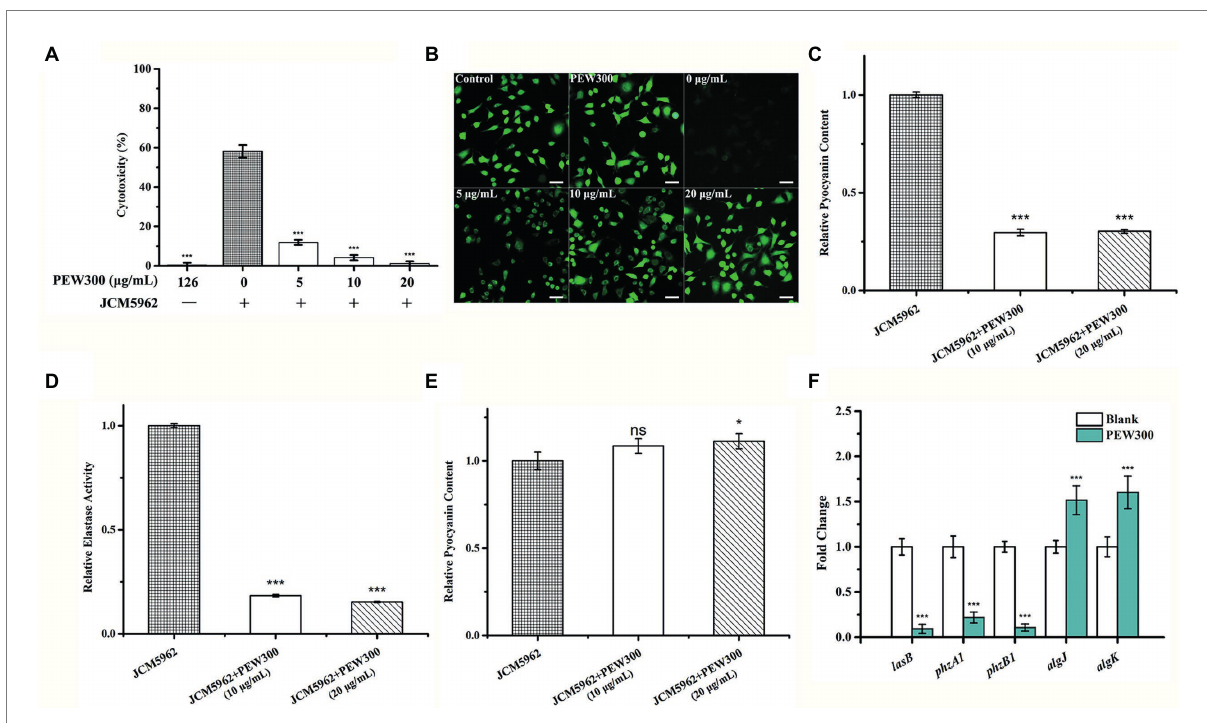
FIGURE 9 Analysis of Pseudomonas aeruginosa virulence factors affected by PEW300. PEW300 results in decreased virulence of P. aeruginosa JCM5962 in A549 cells characterized by (A) CCK-8 assay and (B) calcein-AM staining. *** p < 0.005 compared with P. aeruginosa JCM5962-treated group. Scale bar is 100 μ m. Comparative analysis of (C) pyocyanin content, (D) elastase activity and (E) alginates content in P. aeruginosa JCM5962 treated with or without PEW300 peptide. (F) qPCR analysis of virulence-related gene expression. Data represent the mean ± SD from three independent experiments performed in triplicate. * indicates p < 0.05, *** indicates p < 0.005; ns means no significant difference compared with